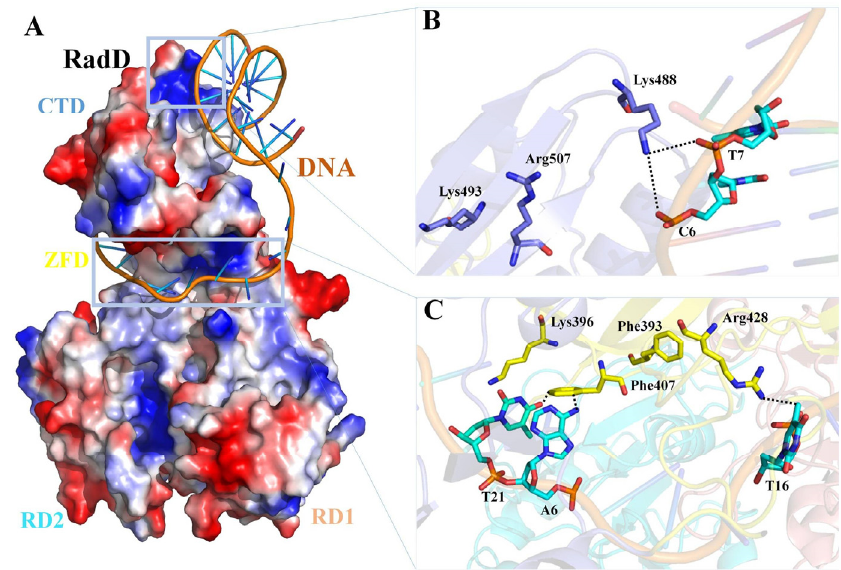
Figure 7. Predictive model of the RadD/DNA complex. ( A ) Surface potential diagram of RadD binding branched DNA. The blue area is shown as the positive charge and the red area is the negative charge, and the branched DNA is shown as a cartoon. ( B ) Interface residues mediating interactions between the RadD-CTD and branched DNA. ( C ) Interface residues mediating interactions between the RadD-ZFD and branched DNA. CTD is shown in blue, ZFD in yellow, DNA in orange, and the bases in cyan.